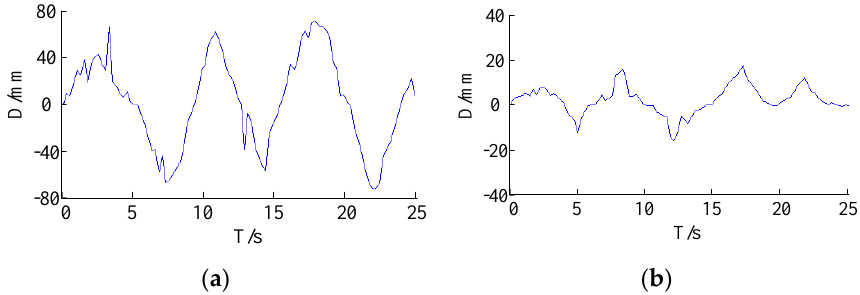
Figure 17. The platform height change: ( a ) Accumulator off; ( b ) accumulator on.